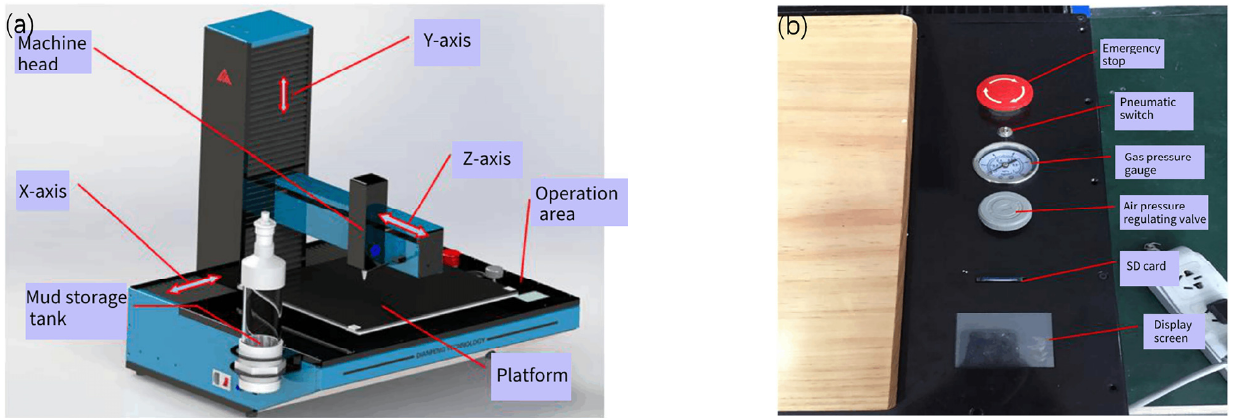
Figure 1. Equipment diagram of Potter Artist-300 printer: ( a ) each component; ( b ) operation inter- face modules. face